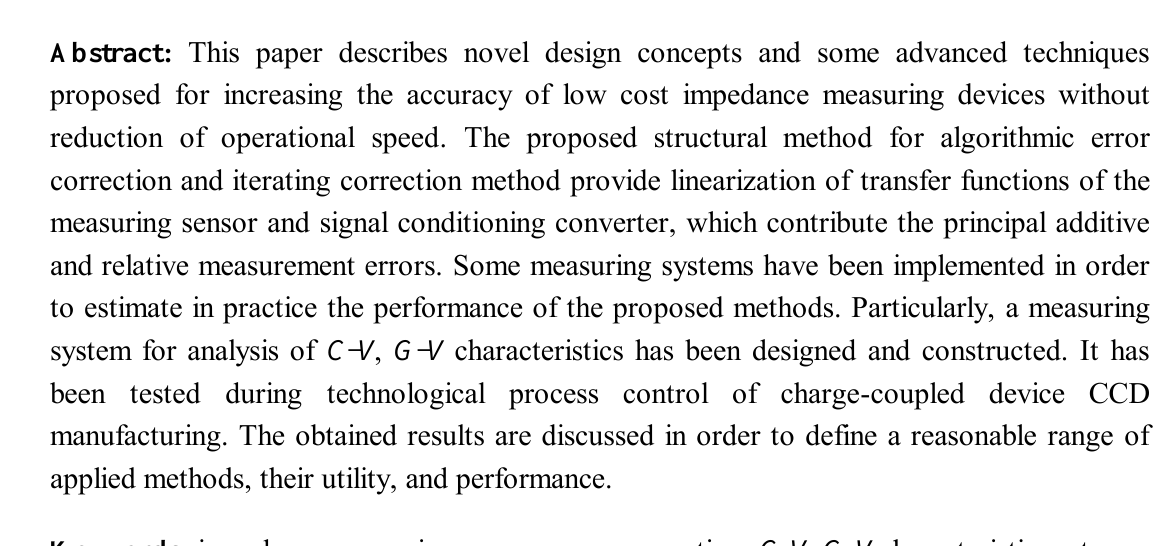
Algorithmic Error Correction of Impedance Measuring